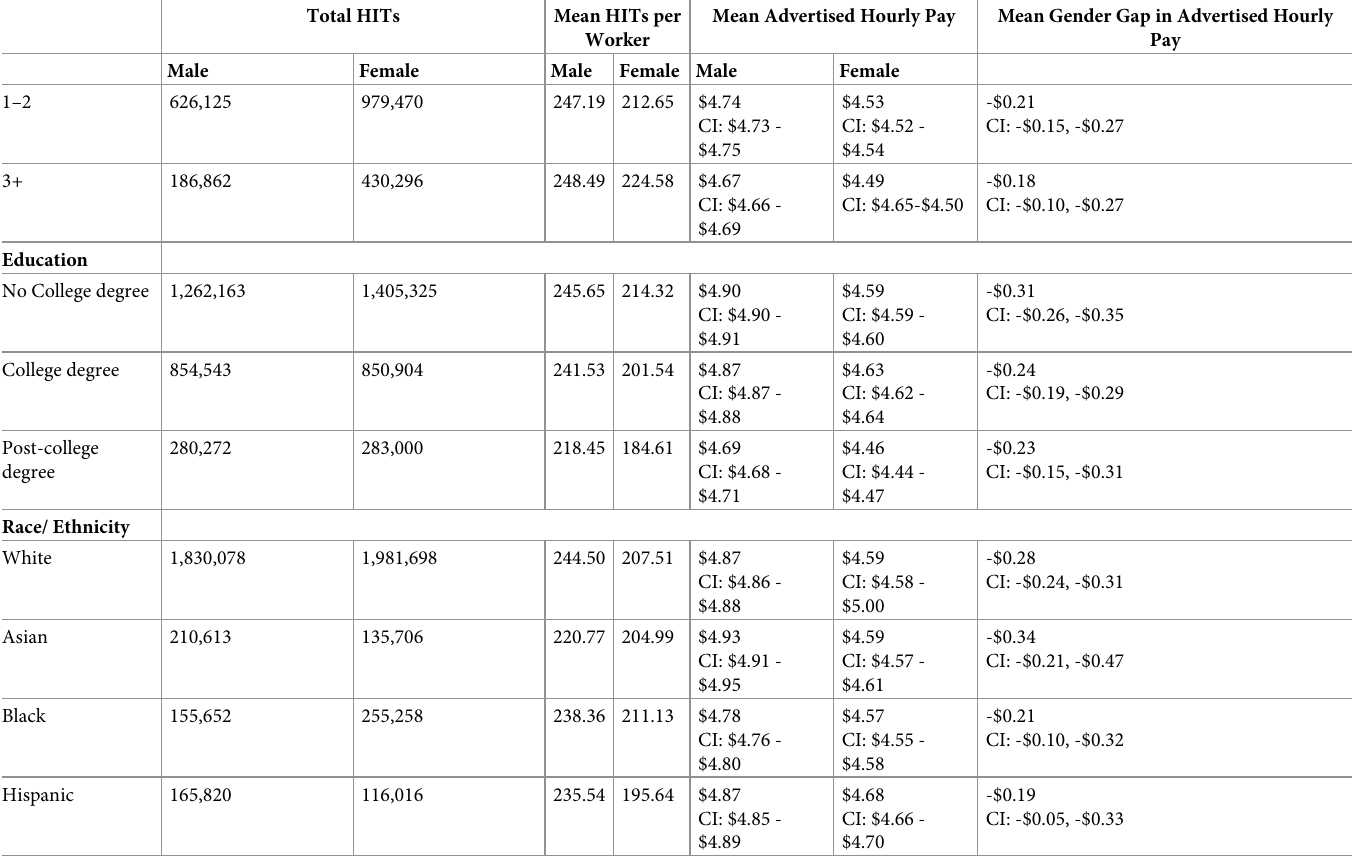
gender difference in advertised hourly pay was observed within each of these four experience groups. The advertised hourly pay for tasks selected by both male and female workers increased with experience, while the gender pay gap decreases. There was some evidence that male workers have more cumulative experience with the platform: 43% of male workers had the highest level of experience (previously completing 1,001–10,000 HITs) compared to only 33% of women. Table 5 also explores the influence of task heterogeneity upon HIT selection and the gender gap in advertised hourly pay. K-means clustering was used to group HITs into 20 clusters ini- tially based on the presence or absence of 5,140 distinct words appearing in HIT titles. Clusters with fewer than 50,000 completed tasks were then excluded from analysis. This resulted in 13 clusters which accounted for 94.3% of submitted work assignments (HITs). The themes of all clusters as well as the average hourly advertised pay for men and women within each cluster are presented in the second panel of Table 5. The clusters included catego- ries such as Games, Decision making, Product evaluation, Psychology studies, and Short Sur- veys. We did not observe a gender preference for any of the clusters. Specifically, for every cluster, the proportion of males was no smaller than 46.6% (consistent with the slightly lower proportion of males on the platform, see Table 1) and no larger than 50.2%. As shown in Table 5, the gender pay gap was observed within each of the clusters. These results suggest